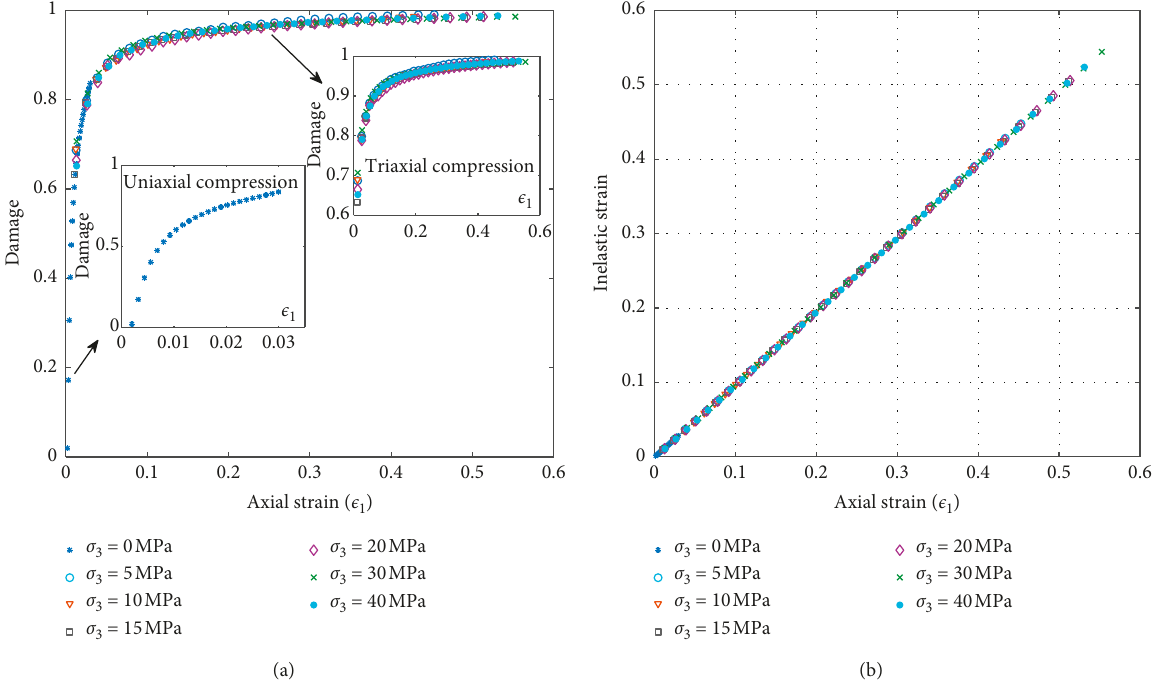
Figure 5: Evolution processes of damage and inelastic strain at different confinements. (a) Damage evolution process. (b) Variation of inelastic